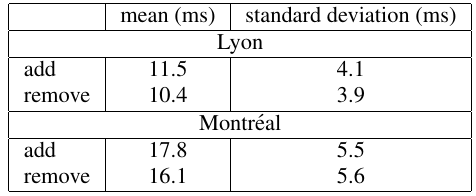
Table 1: Add and remove operations performance.